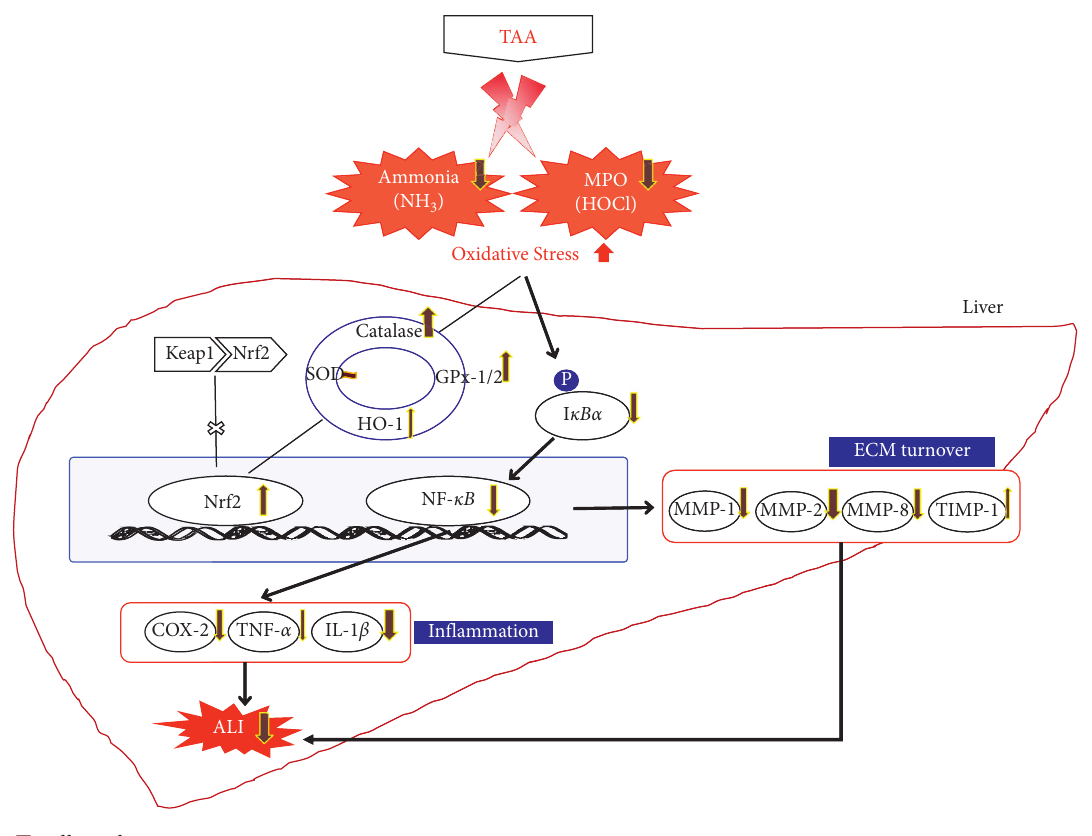
Figure 7: Predicted mechanisms in liver tissue on UR200